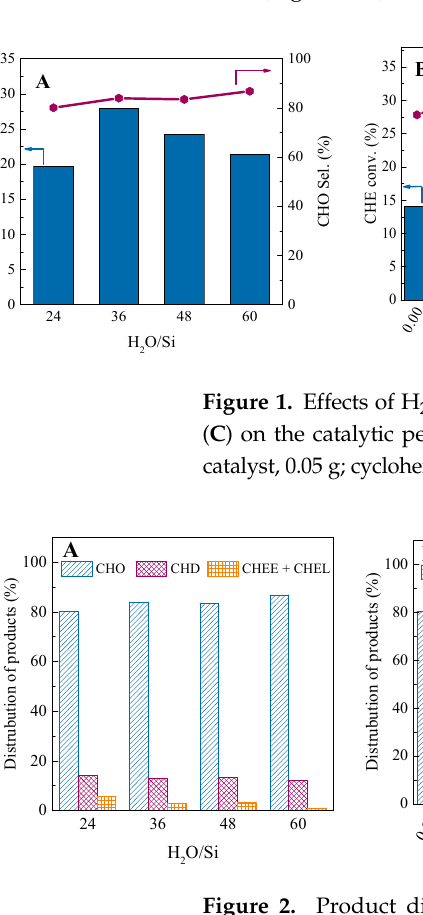
Figure 2. Product distribution for cyclohexene epoxidation with Re − Ti − Beta as the catalyst. The Re − Ti − Beta was postsynthesized at different H 2 O/Si molar ratios ( A ), TEAOH/Si molar ratios ( B ) and treatment temperatures ( C ). The products included epoxycyclohexane (CHO), 1,2 − cyclohexanediol (CHD), cyclohex − 2 − en − 1 − ol (CHEL) and cyclohex − 2 − en − 1 − one (CHEE). Reaction conditions: catalyst, 0.05 g; cyclohexene, 10 mmol; H 2 O 2 (30 wt.%), 10 mmol; MeCN, 10 mL; temp., 333 K; time, 2 h.